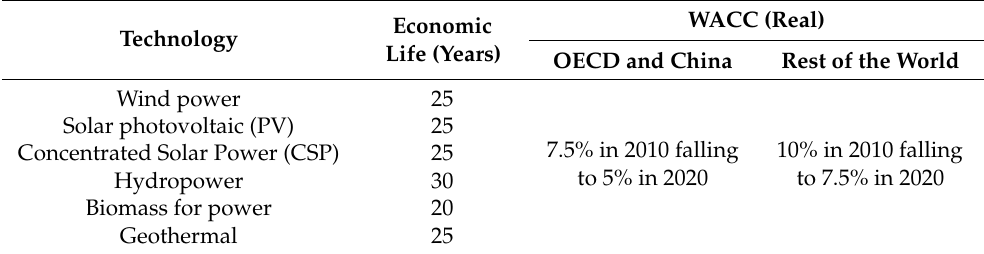
Table 2. Standardised assumptions for LCOE calculations